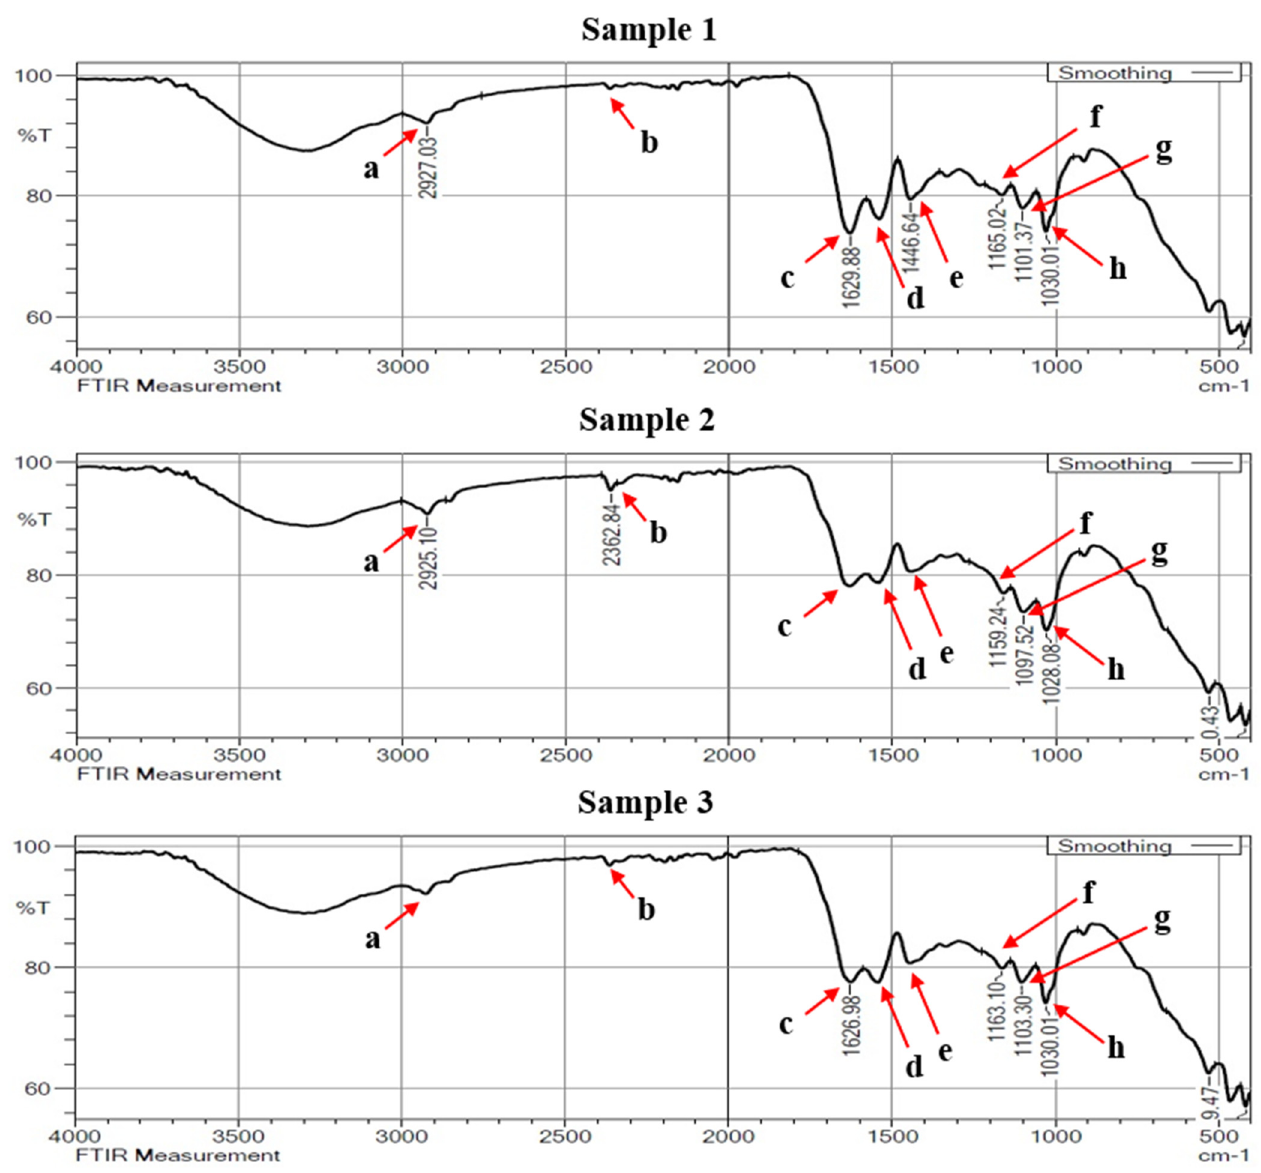
Figure 8. FTIR spectra of buffalo leather samples 1 to 3.